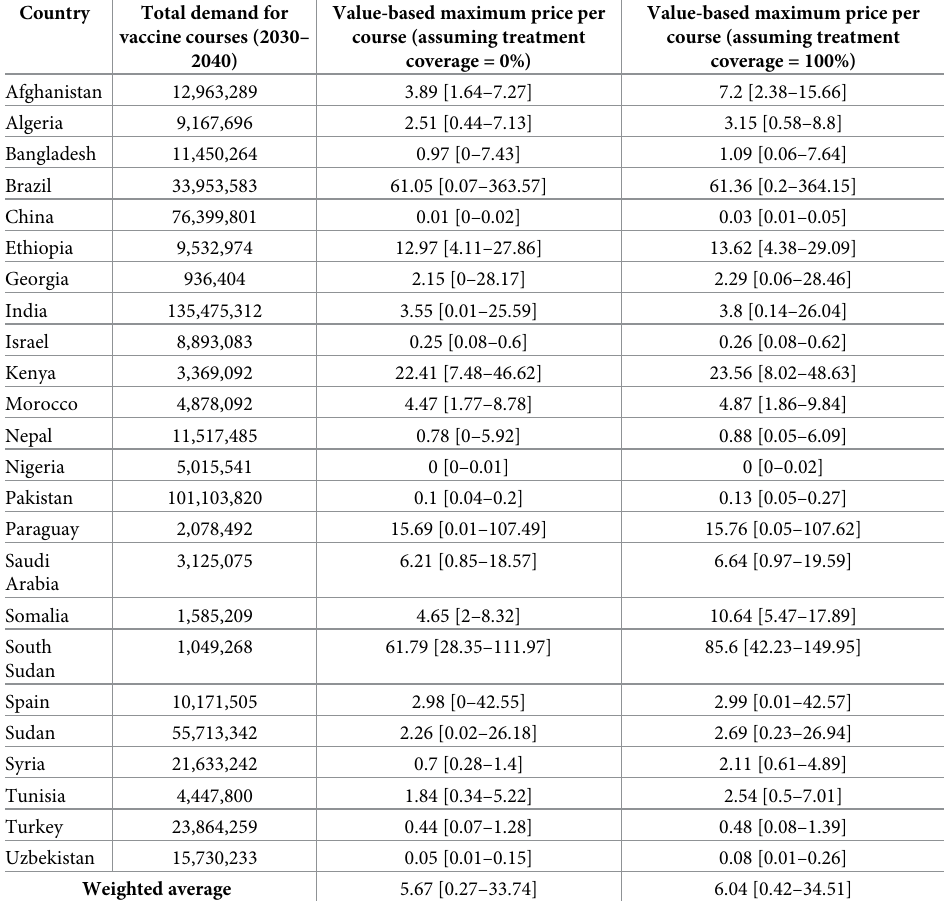
Table 3. Value-based maximum price for a leishmaniasis vaccine course (2030–2040). Country